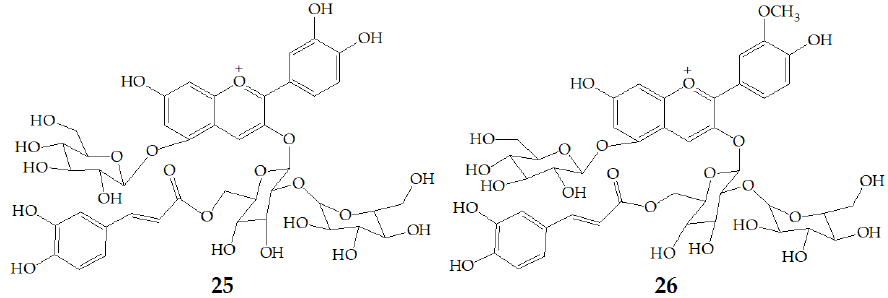
Figure 6. Chemical structures of compound 25 , 26 .